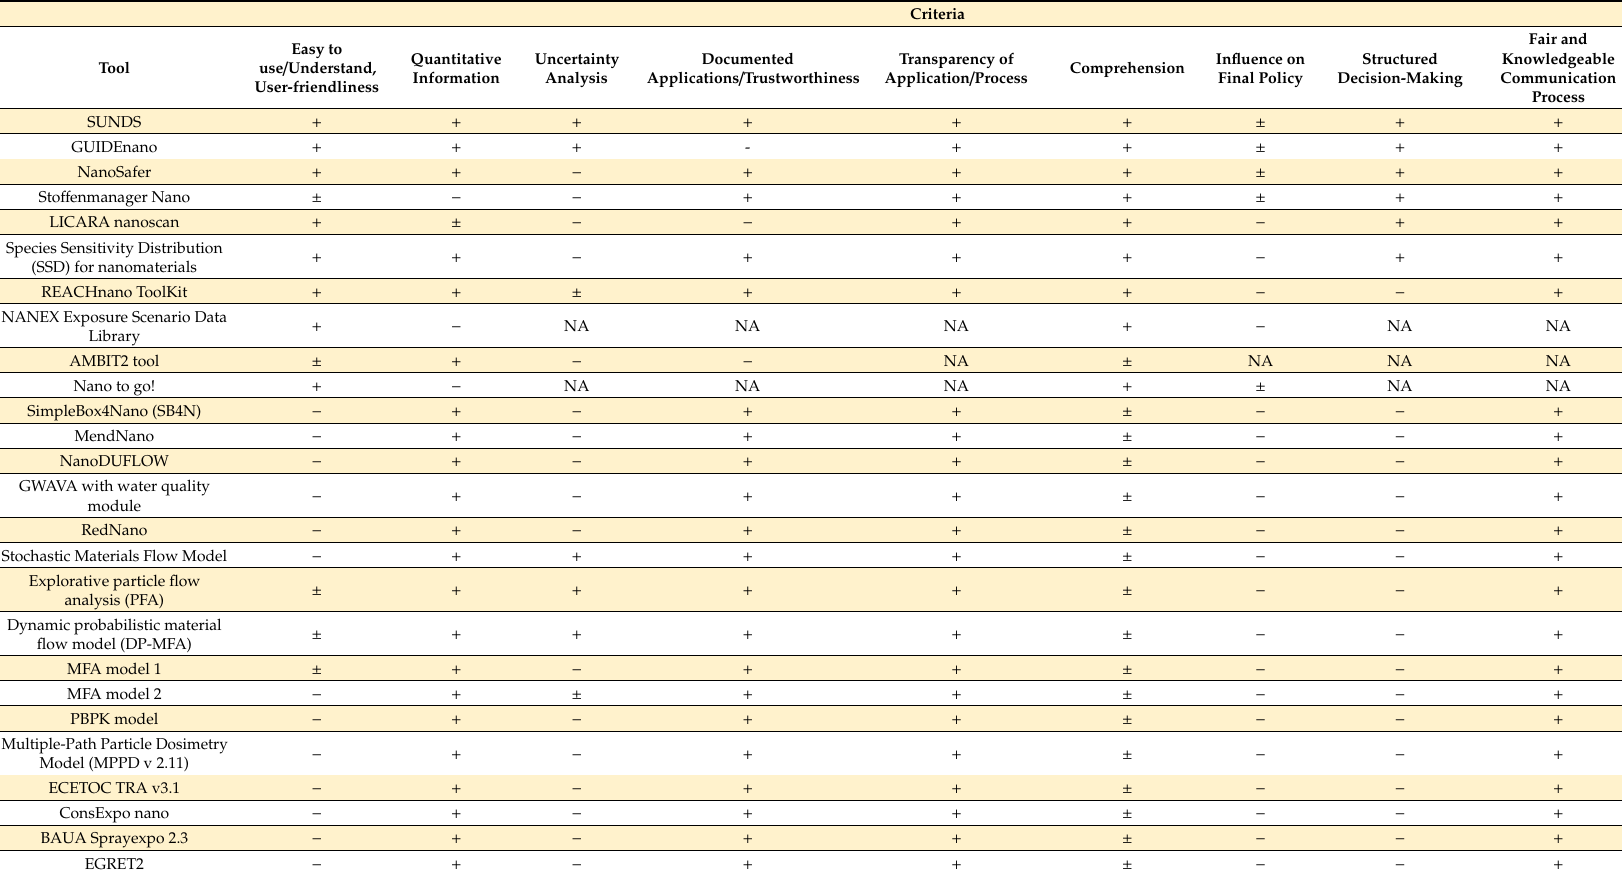
Table 3. Evaluation of the Risk and concern / safety assessment tools, according to 9 relevant criteria. + Criterion fulfilled; − Criterion not fulfilled; ± Criterion not fully fulfilled; NA Criterion not applicable /